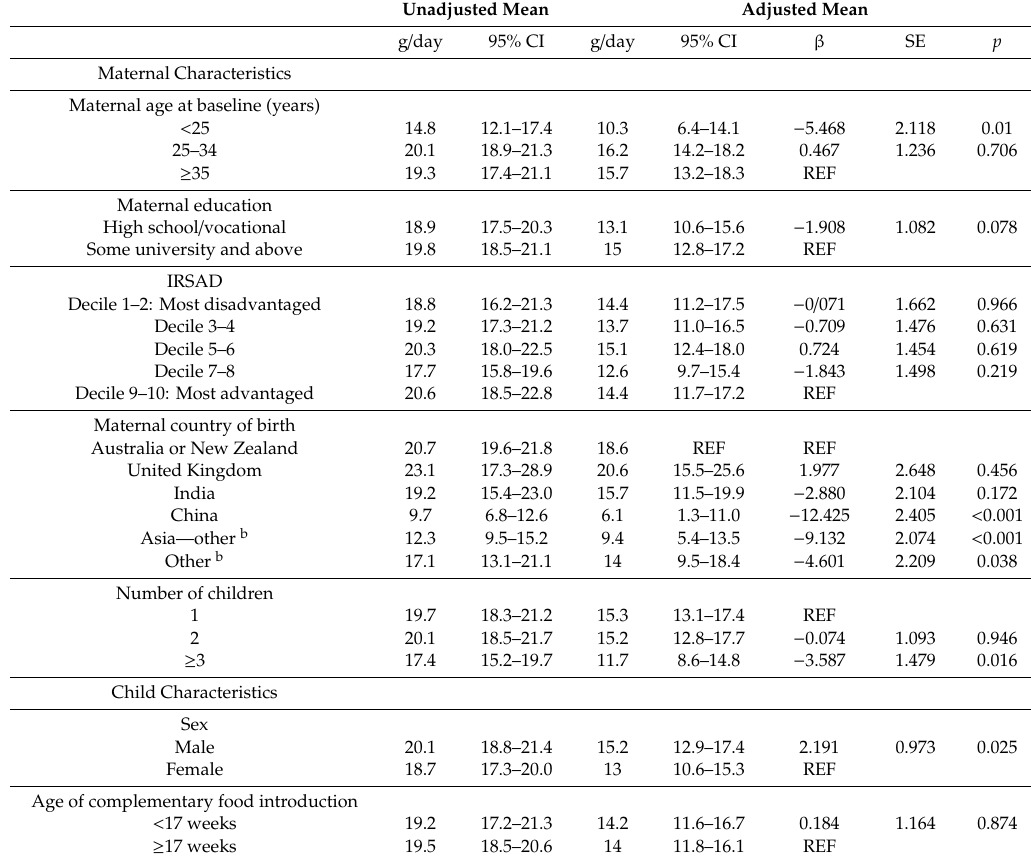
Table 3. Factors independently a associated with usual wholegrain intakes of children aged 12–14 months (unadjusted and adjusted mean values and 95% confidence interval) ( n = 828). Unadjusted Mean Adjusted Mean g / day 95% CI g / day 95% CI β SE